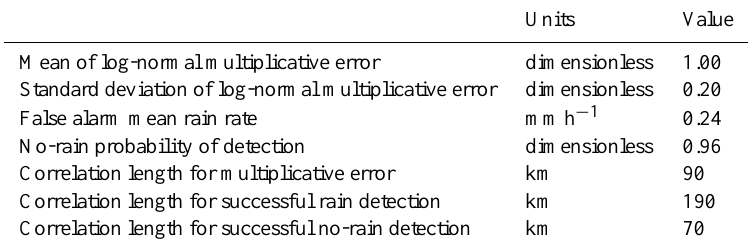
Table 3. SREM2D parameters.